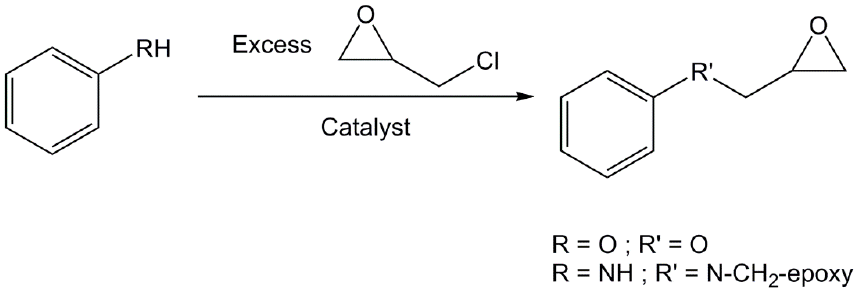
Scheme 2. Mechanism of coupling between phenolic compounds and epichlorohydrin (ECH) in the presence of a phase transfer catalyst (QX)